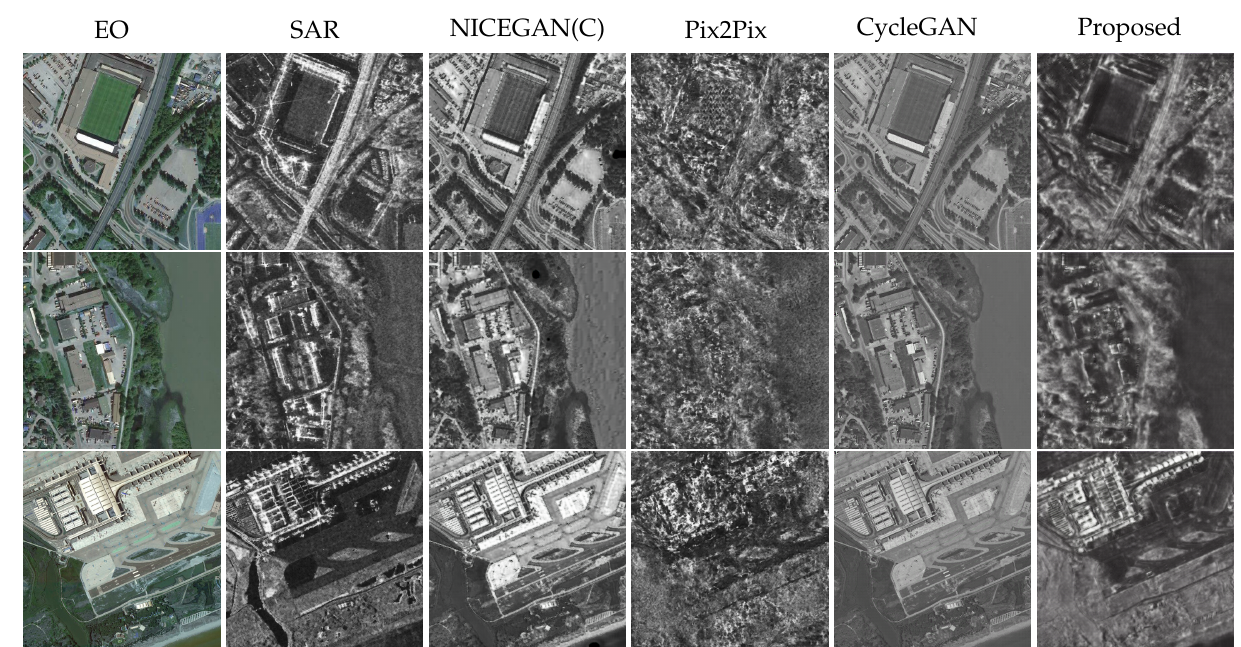
Figure 11. Visual samples of different methods for the E2S translation task on the SAR2Opt